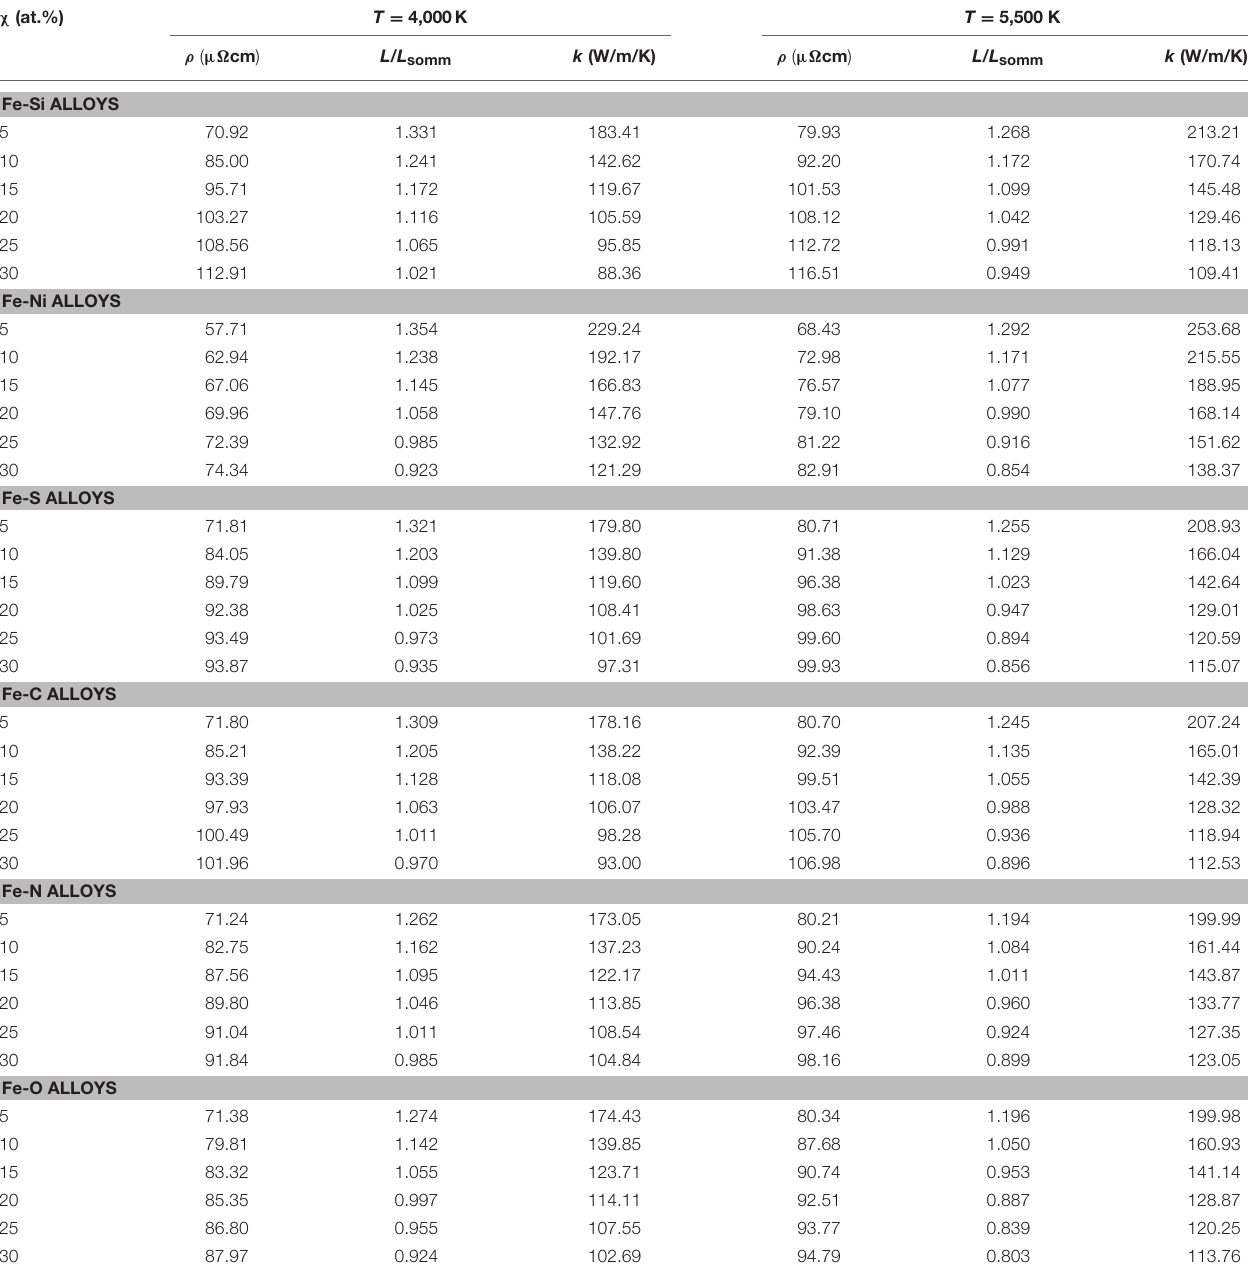
TABLE 2 | Transport properties of Fe-alloys at the Earth’s outer core ( V = 16.27 Å 3 ). χ